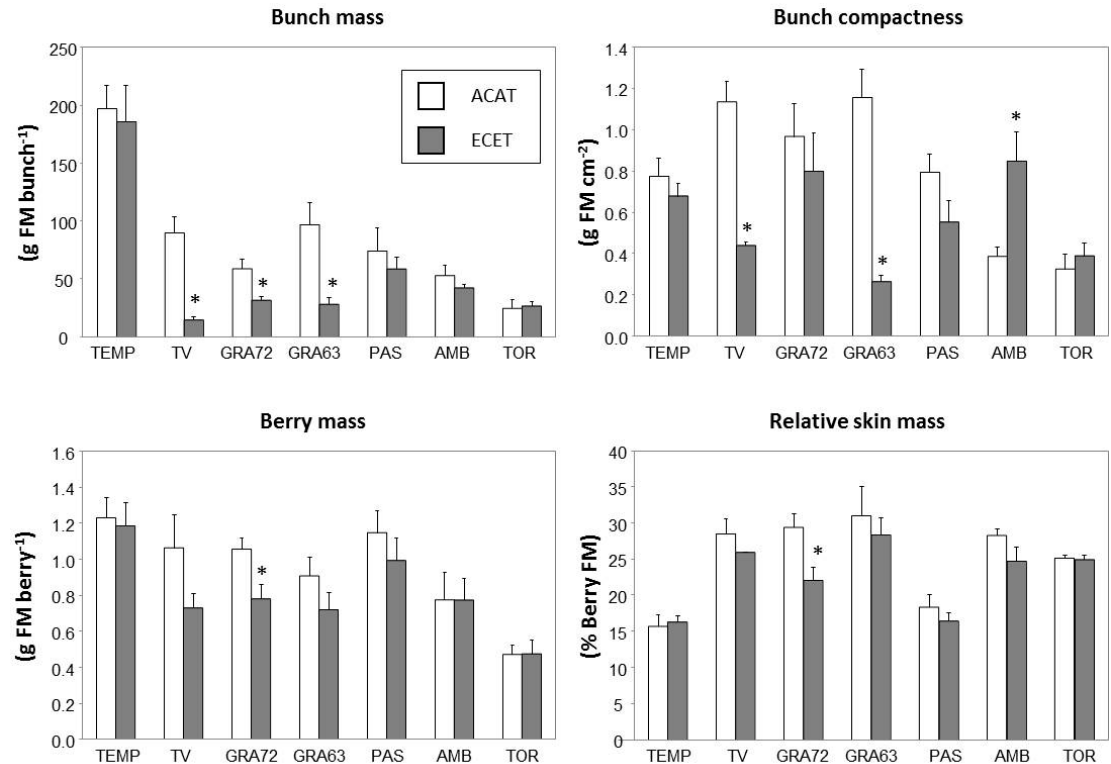
Figure 1. Bunch and berry characteristics from fruit-bearing cuttings of genotypes from seven local old grapevine varieties recovered in Navarre (Spain) grown under two climate scenarios during berry ripening: (1) ambient CO 2 (400 ppm) and ambient temperature (T) (ACAT) and (2) elevated CO 2 (700 ppm) and elevated temperature (T + 4 °C) (ECET). Values are means ± S.E. (n = 3–6). Within each genotype, asterisks (*) indicate significant differences ( p < 0.05) between treatments according to Duncan’s test. Genotype labels can be found in Table 5.